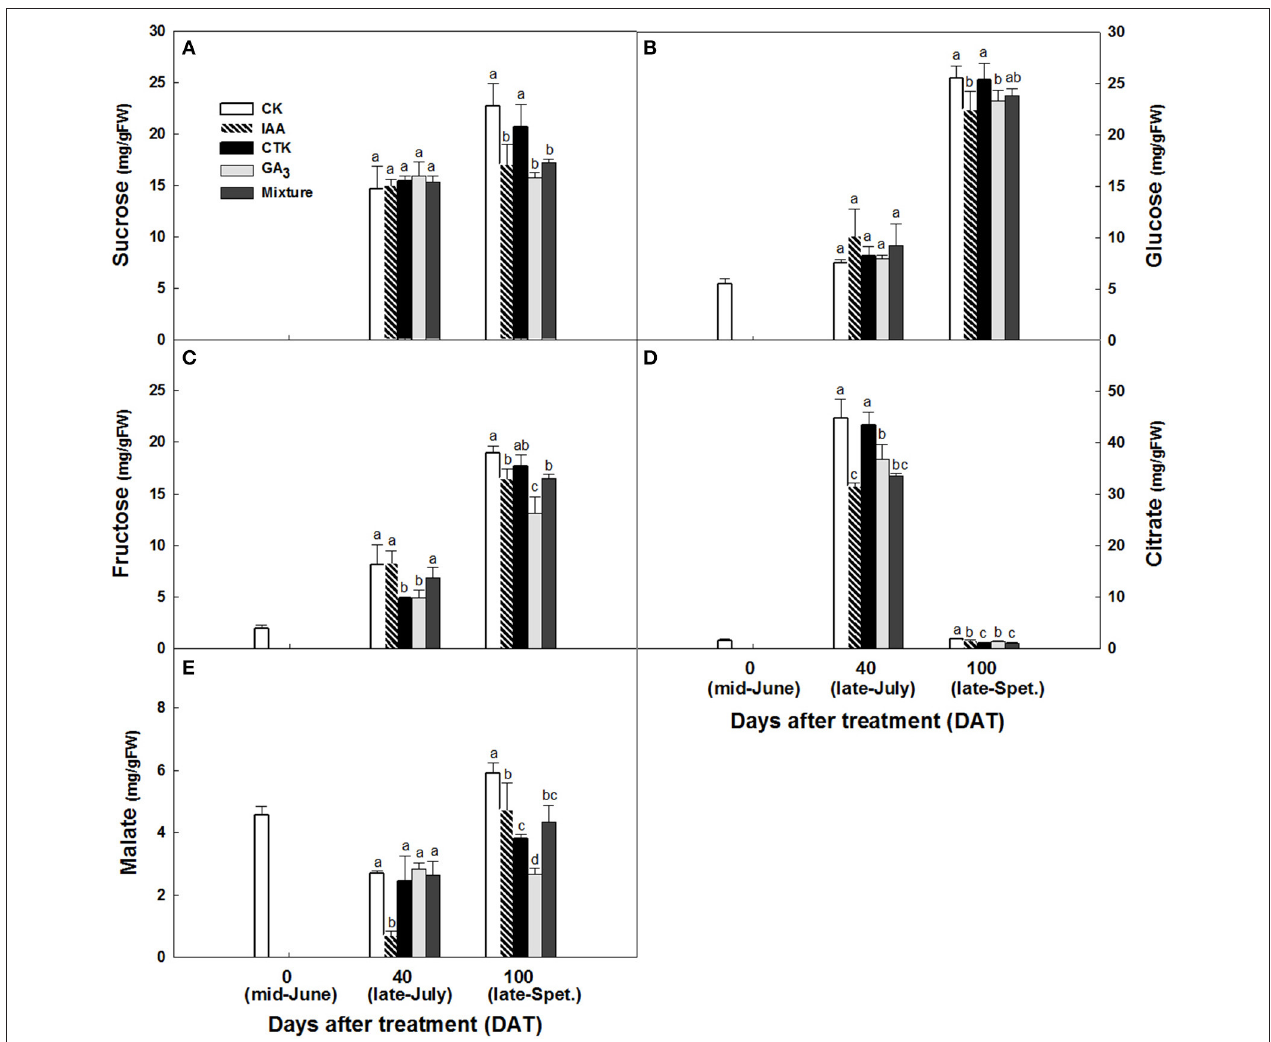
FIGURE 9 | Sucrose (A) , glucose (B) , fructose (C) , citrate (D) and malate (E) accumulation in peel after hormone treatment. Different letters mean significant difference at P <